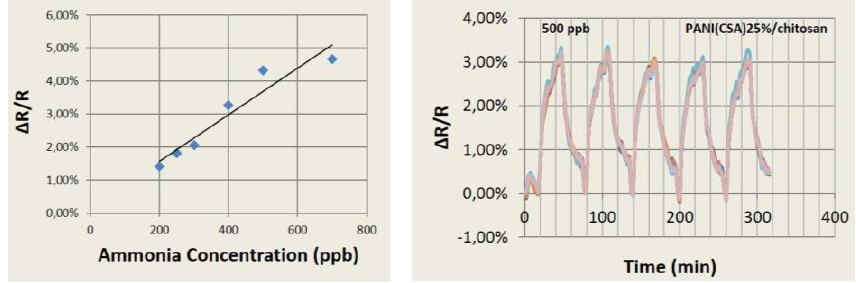
Figure 7. Response of PANI Chitosan composite to ammonia in the sub ppm